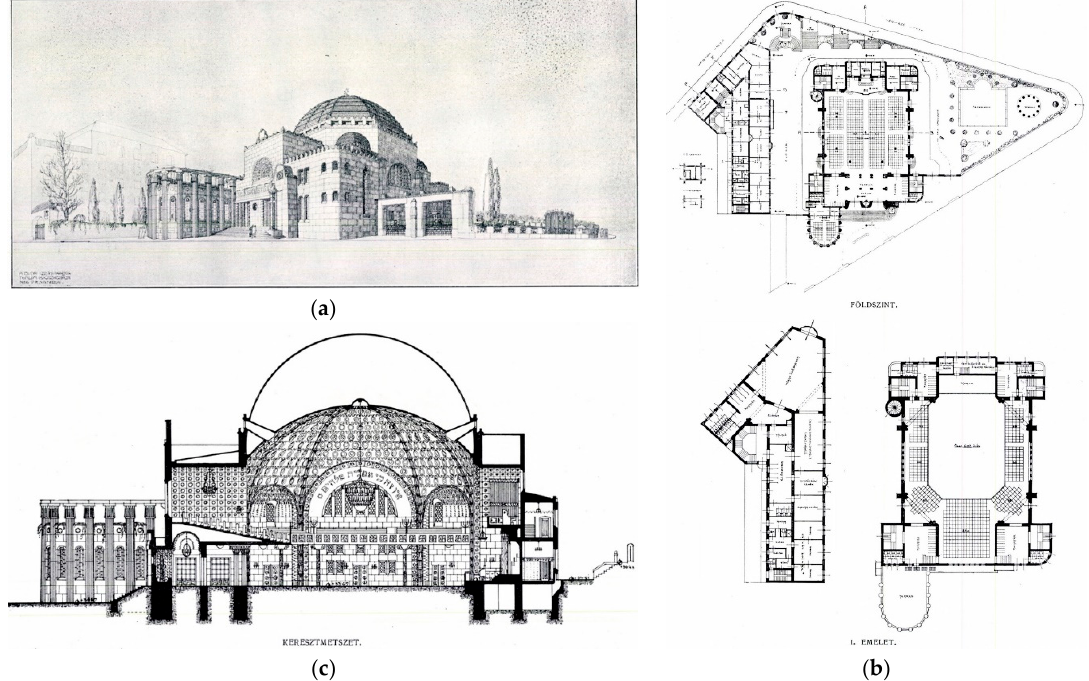
Figure 3. ( a ) Perspective view of Sándor and Béla Löfflers 3rd prize design (Sándor and Béla Löffler, 1912). Source: Magyar E ́ pi ́ to ̋ mu ̋ ve ́ szet 1912, p. 21. ( b ) Floor plan of the Buda synagogue (Sándor and Béla Löffler, 1912). Source: Magyar E ́ pi ́ to ̋ mu ̋ ve ́ szet 1912, p. 25. ( c ) Cross-section (Sándor and Béla